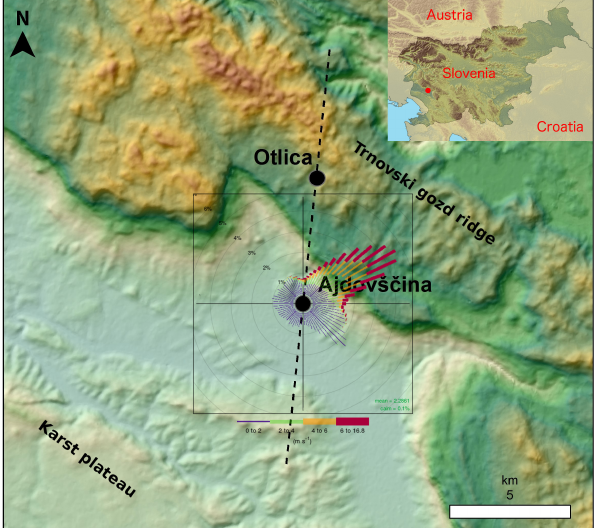
Figure 1. Terrain configuration of the Vipava valley [34] and its location in central Europe (inlay, licensed under https://creativecommons.org/licenses/by-sa/3.0 (CC BY-SA 3.0) by A. Mladenovic). Towards the Adriatic coast in the south-west, the valley (125m above the sea level) is closed by the Karst plateau (up to 300m a.s.l.), while to the north-east the terrain rises steeply to the Trnovski gozd plateau (up to 1200m a.s.l.). Measurement sites, horizontally displaced by about 5km, are marked by black points. The wind rose shows wind speed and direction distribution in Ajdovšˇcina for the Bora outbreak on 8 September 2017. Predominant direction was NE, with speeds exceeding